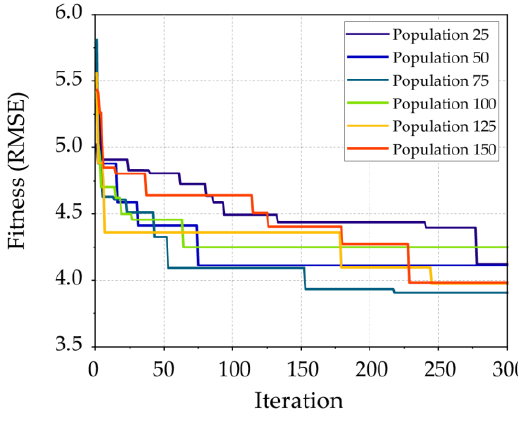
Figure 5. SOA–RF model development.